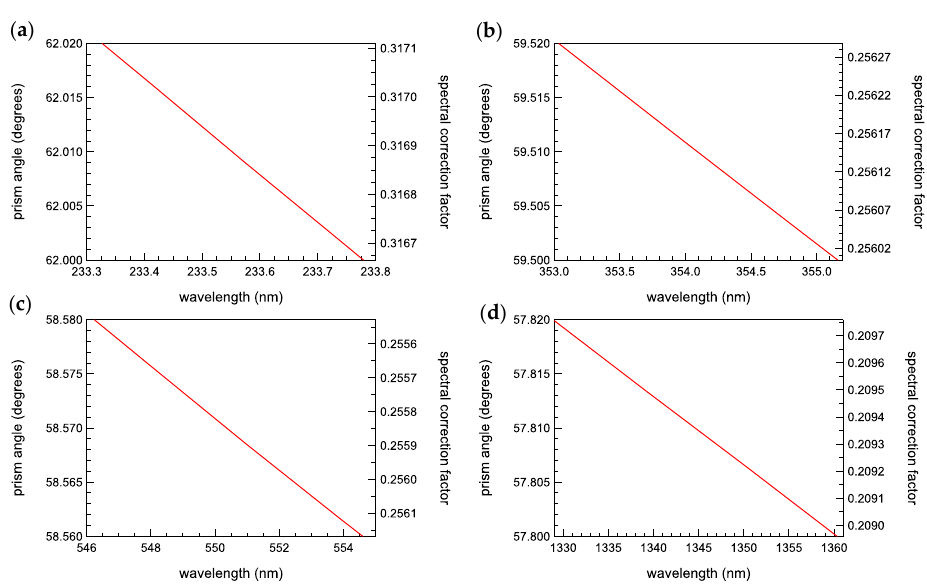
Figure 15. Four specific wavelength regions (UV to near-IR) showing the linearity of the full spectral correction factors over the exit slit width (covered by 0.02° prism angle rotation) at the focal plane. Prism angle shown represent scans centered at 233.5 nm, 354 nm, 550 nm, and 1345 nm for panels ( a – d ), respectively. Correction factors (right axis) include the spectrally dependent terms representing all wavelengths covered by the prism scans across the passband defined by the central laser wavelength (see Figure 11—total correction curve).